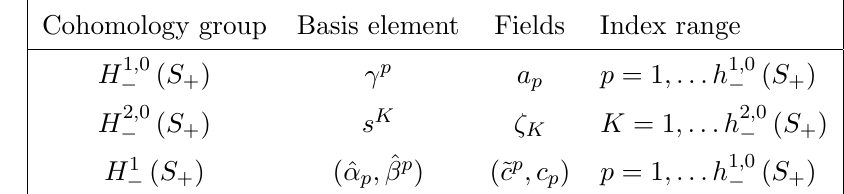
Table 2 . Cohomology groups on the D7-brane divisor S + . The dimensions are denoted by h p;q dim H p;q . While (cid:13) p and s K are complex basis elements, the forms (^ (cid:11) p ; ^ (cid:12) p ) constitute a real basis. (cid:6)